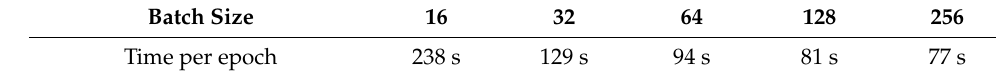
Table A2. The training time per epoch based on different batch sizes.